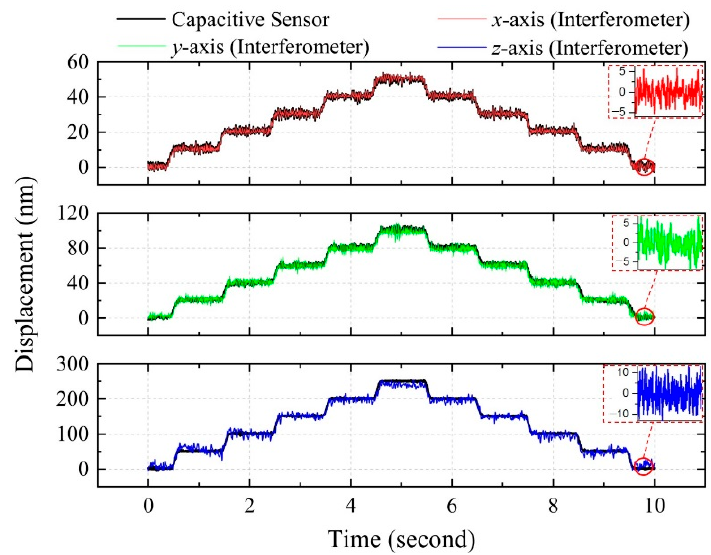
Figure 8. Measurement results of the step displacement tests.